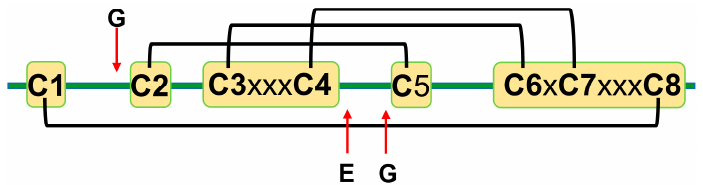
Figure 1. A schematic representation of plant defensins. Letters denote conserved amino acids. The conserved number of amino acids (x—any amino acid) separates cysteines C3 and C4 (three amino acids), C6 and C7 (one amino acid), and C7 and C8 (three amino acids). Letters and red arrows denote conserved amino acids and their approximate locations in the amino acid sequence, respectively. Black brackets represent disulfide bonds.